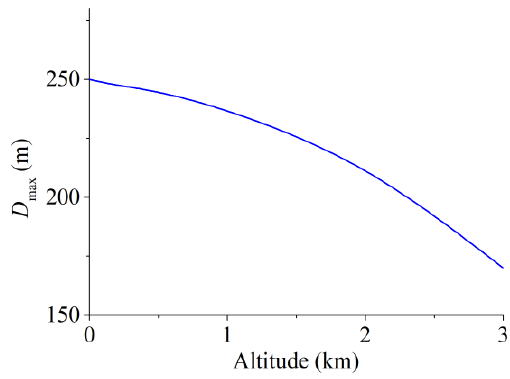
Figure 9. The variation of D max with changing altitude.